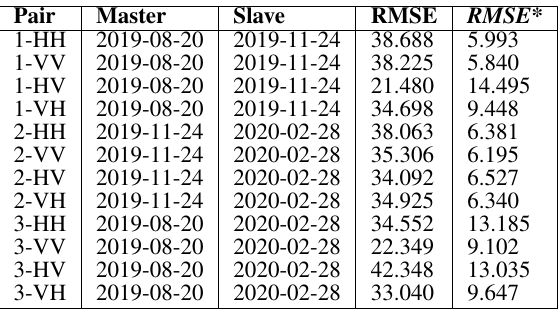
Table 3. Summary of Root Mean Square Errors calculated for the four polarimetric channels, in meters. RMSE corresponds to pro- cessing workflow B (no orbital correction applied), and RMSE* corresponds to workflow A (orbital correction applied)